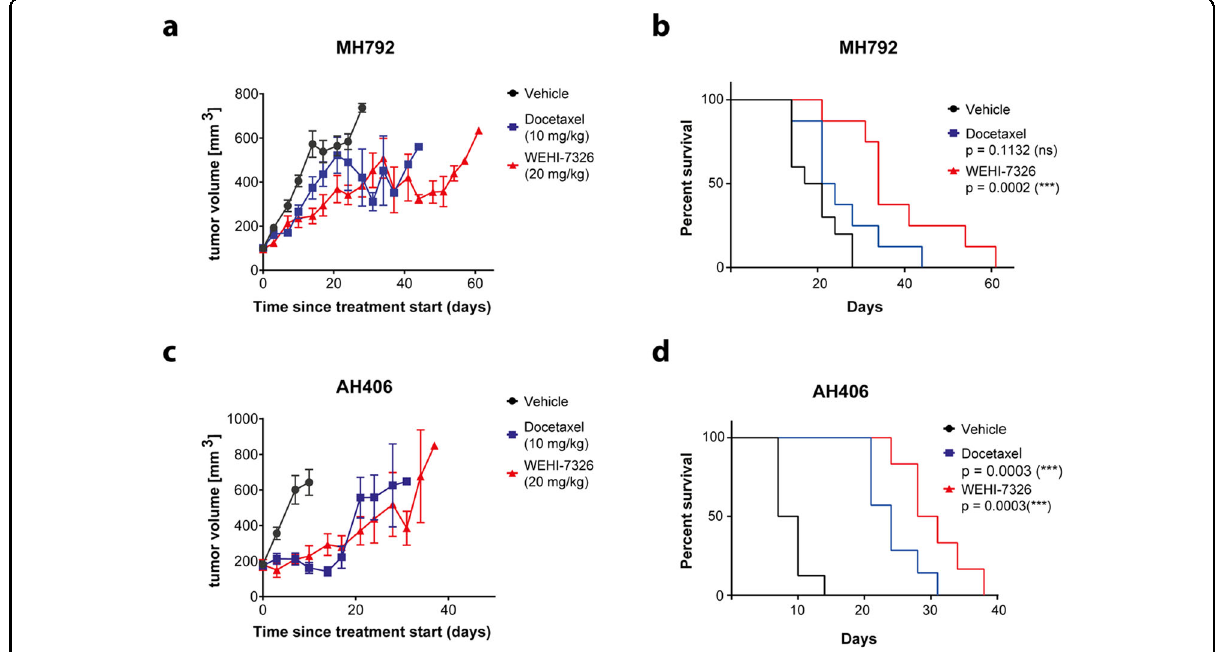
Fig. 5 Ef fi cacy of WEHI-7326 in cisplatin-refractory patient-derived xenograft mouse models of lung squamous cell carcinoma. a , b Tumor growth curve ( a ) and Kaplan – Meier survival plot ( b ) of MH792 LUSC PDX recipient male mice treated with either docetaxel (10 mg/kg, i.p.; once) or WEHI-7326 (20 mg/kg, i.v.; twice a week). p (docetaxel) = 0.1131 (ns), p(WEHI-7326) = 0.0002 (***) compared to vehicle control; p-values obtained through Log-rank (Mantel – Cox) test, n = 8 – 10 mice. Adverse effects in WEHI-7326 arm: 1 with hind limb paralysis after 4 weeks of treatment. c , d Tumor growth curve ( c ) and Kaplan – Meier survival plot ( d ) of AH406 LUSC PDX recipient male mice treated with either docetaxel (10 mg/kg, i.p.; once) or WEHI-7326 (20 mg/kg, i.v.; twice a week). Vehicle mice were administered the vehicle for WEHI-7326. p(docetaxel) = 0.0003 (***),